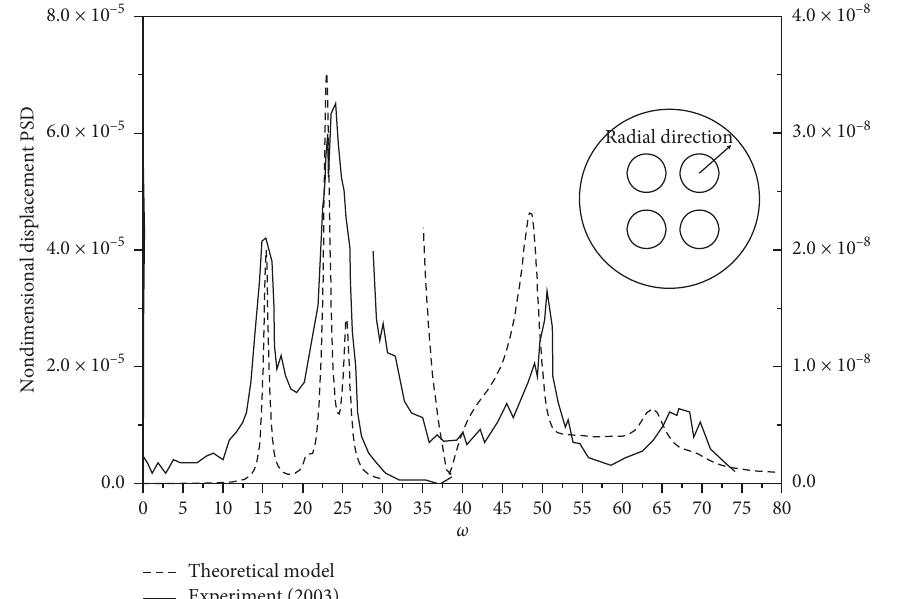
Figure 3: Comparison of theoretical and experimental PSD of midcylinder displacements in a four-cylinder system in the radial direction. The scales on the left are for the first mode group, while those on the right are for the second group.